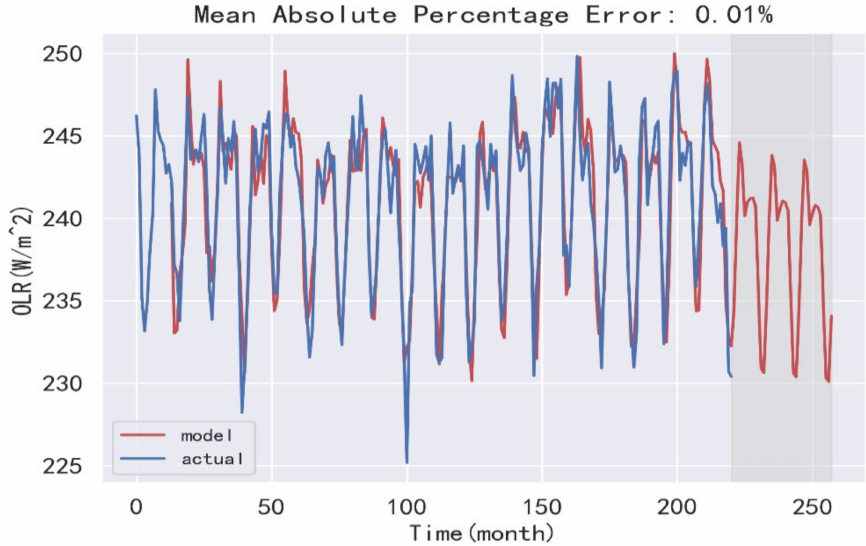
Figure 10. Model residual test and